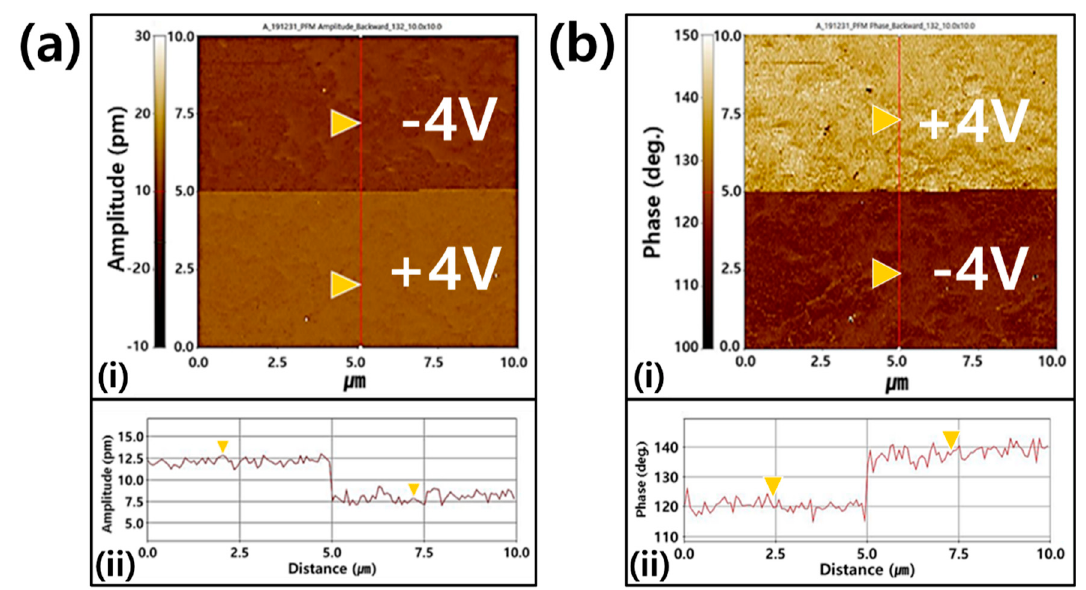
Figure 3. Piezoelectric force microscopy (PFM) image based on the FWPG in a 10 × 10 µ m 2 area; ( ai ) Image of amplitude contrast by using poling bias of ±4 V. ( aii ) Graph of amplitude local switching spectroscopy. ( bi ) Image of phase contrast by using poling bias of ±4 V. ( bii ) Graph of phase local switching spectroscopy.